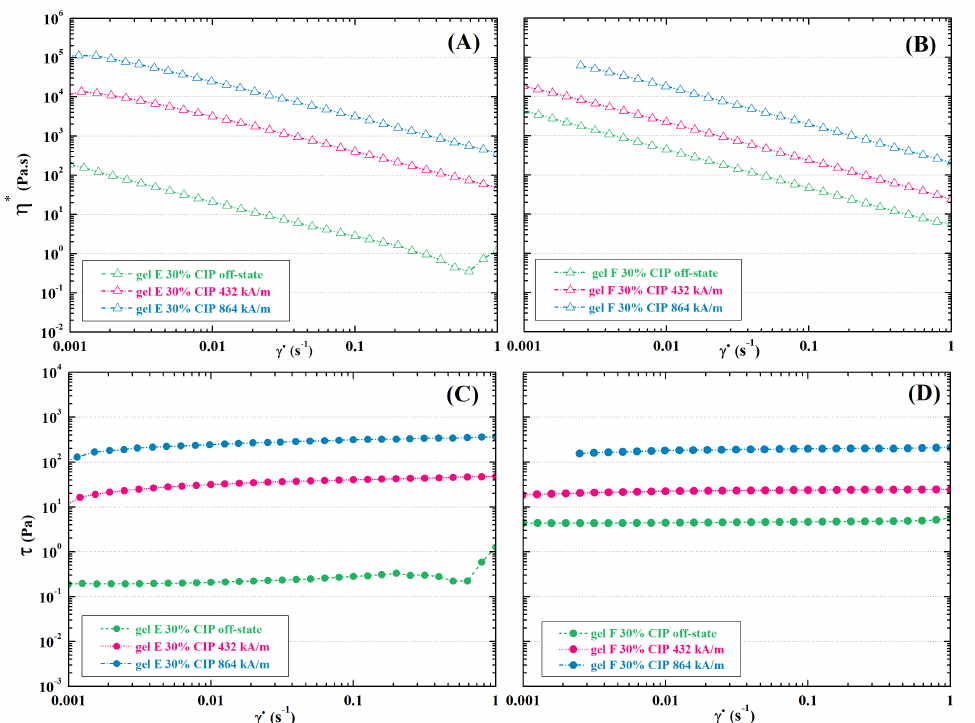
Figure 12. Shear-flow characterisation of CIP-filled Schiff base cross-linked gels: ( A , B ) Complex viscosity –shear rate curves and ( C , D ) shear stress–shear rate curves of gel E-CIP ( A , C ) and gel F-CIP ( B , D ) in an external magnetic